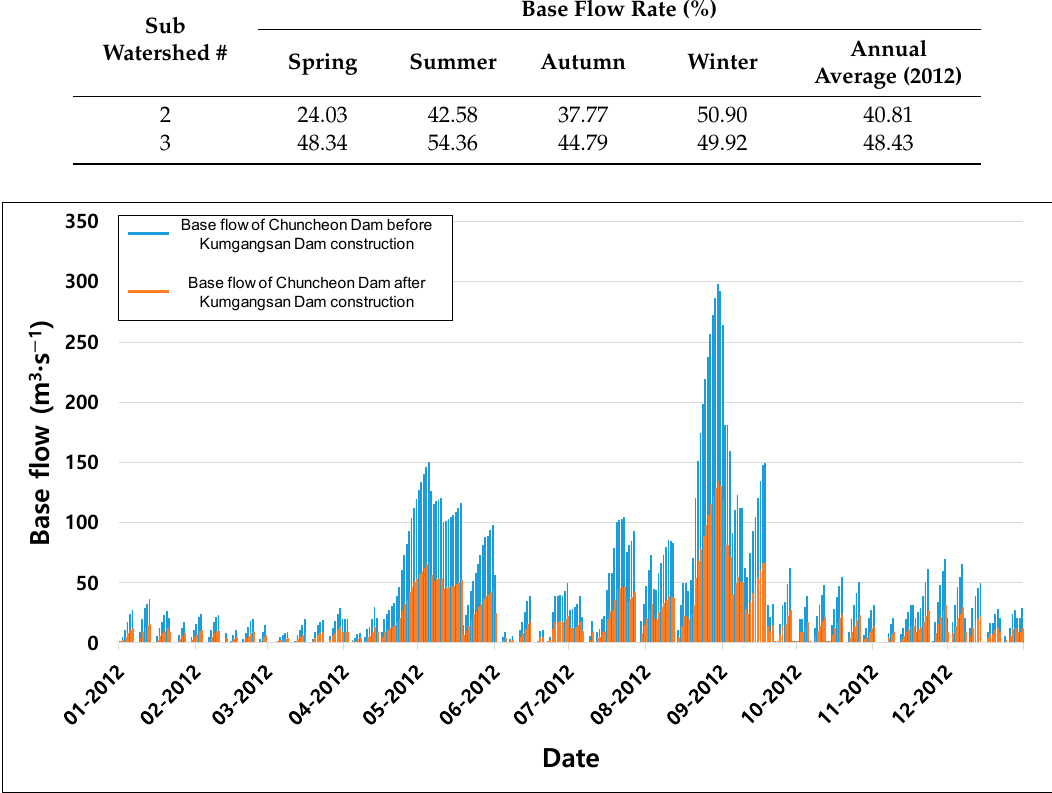
Table 8. Seasonal and annual average base flow rates for natural flow in WSG 4 (subwatersheds 2 and 3).